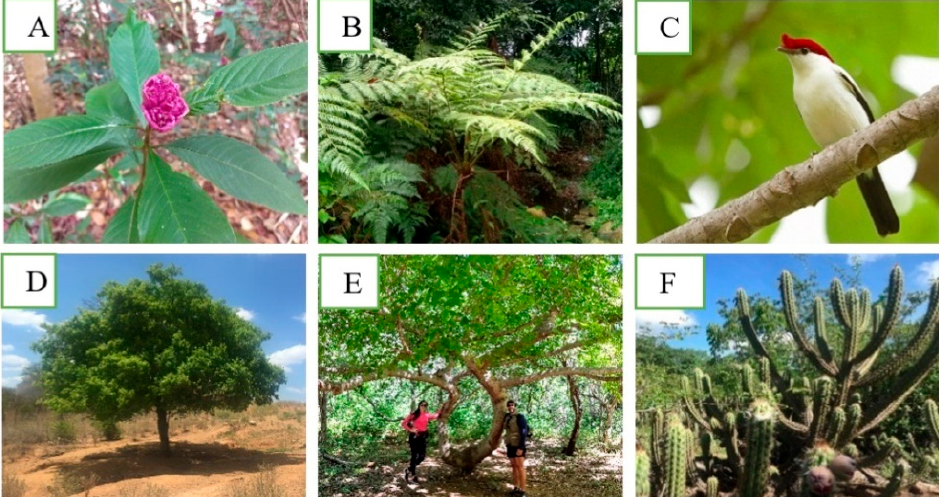
Figure 5. Biodiversity on Riacho do Meio ( A – C ) and Santo Sepulcro ( D – F ) trail, Araripe UGG. ( A )— Palicourea colorata ; ( B ) —Cyathea sp.; ( C )— Antilophia bokermanni ; ( D )— Ziziphus joazeiro ; ( E )— Spondias tuberosa ; ( F )— Xiquexique gounellei. Source: ( A , C – F ) Research Collection; ( B )—[77].